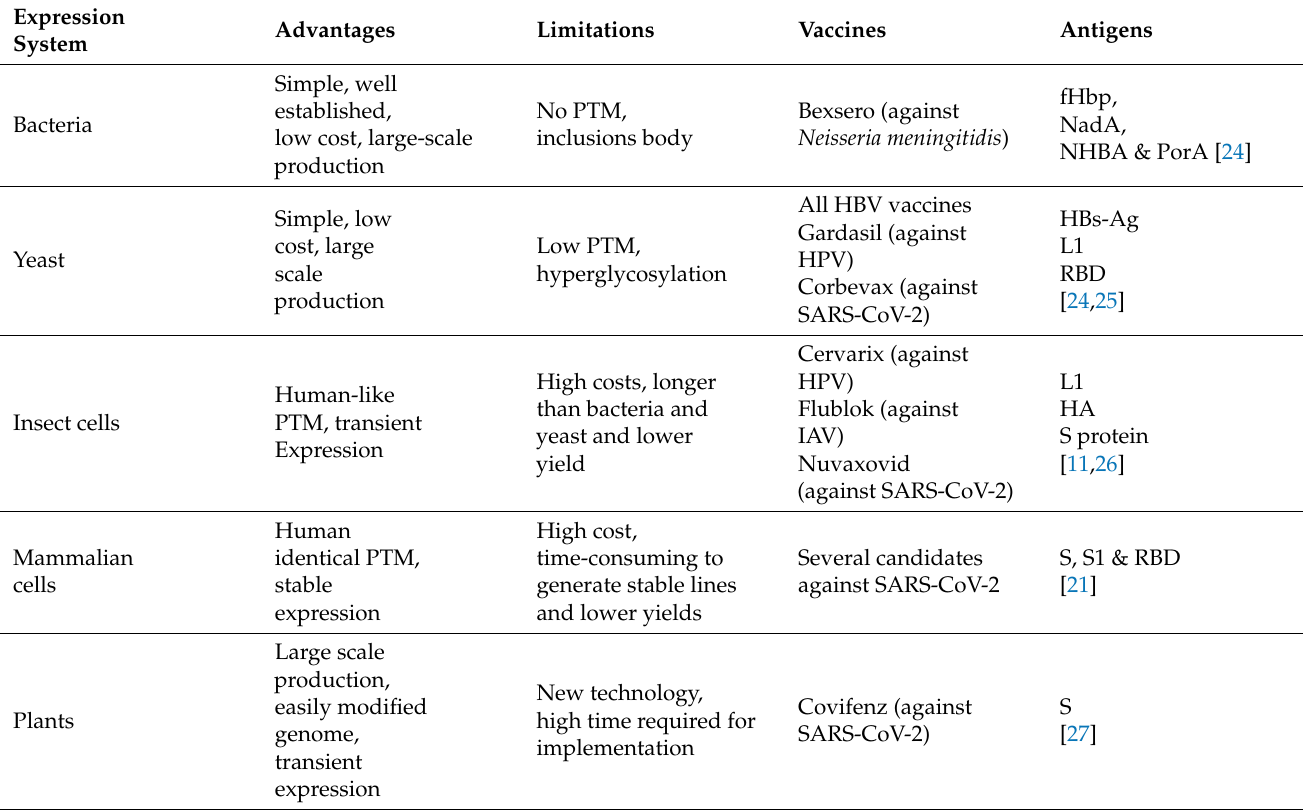
Table 1. Expression systems to produce protein subunit